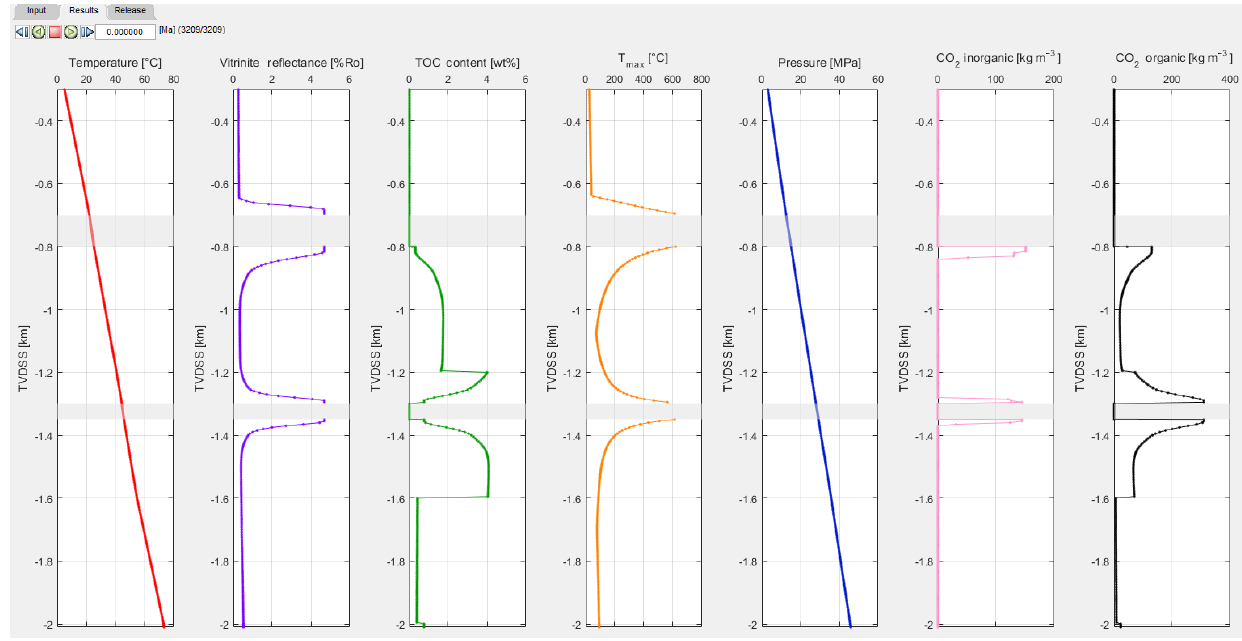
Figure 3. Snapshot of the results tab generated for a hypothetical sedimentary column with two sill intrusions and three eroded layers. Right-clicking any curve allows the user to copy curve data.